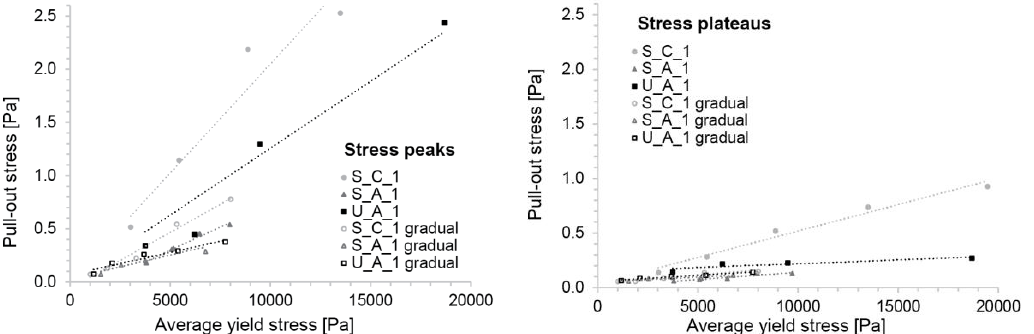
Figure 13. Relation of pull-out stresses to average yield stress measured by the penetrometer. ( Left ) peak pull-out stress, ( right ) plateau pull-out stress. Both graphs show the three concrete compositions and the two filling modes.